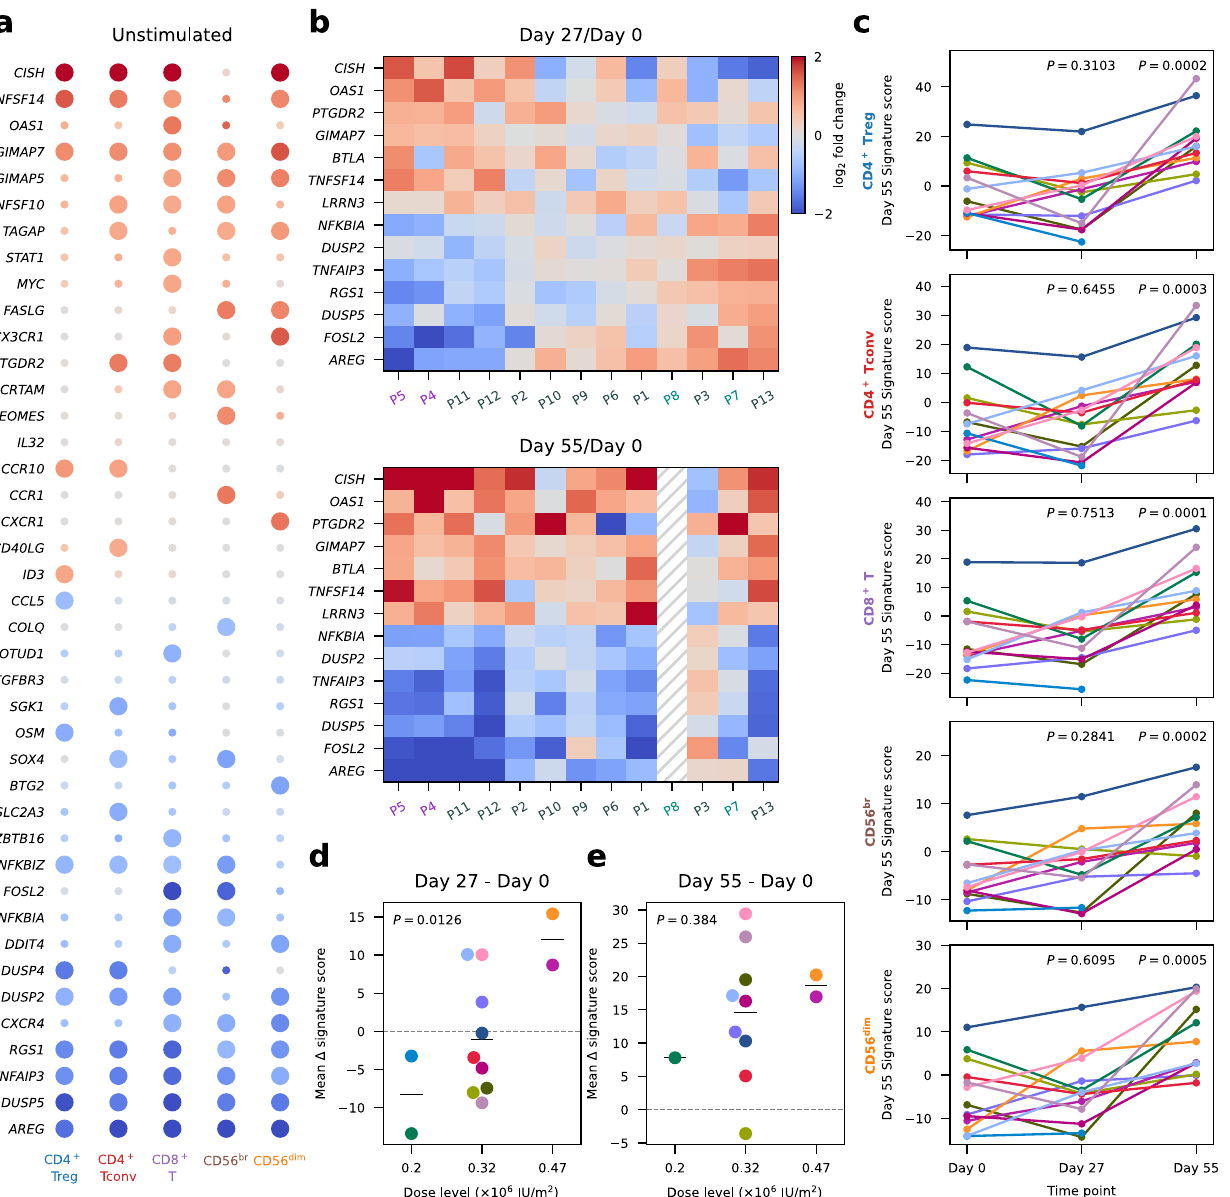
Fig. 6 | Interval low-dose IL-2 immunotherapy induces a long-lasting anti- in fl ammatory gene expression signature. a Differential expression of Day 55 signature genes. Day 55 signature genes were de fi ned as the 41 genes sig- ni fi cantly differentially expressed in at least one cell population comparing Day 55 with Day 0. Dot colours represent log 2 fold-change between Day 0 and Day 55. Larger dots represent signi fi cantlydifferentiallyexpressedgenes. Fold changeand P values were calculated using a generalized linear model implemented in DESeq2 (see “ Methods ” ). b Participant-speci fi c differential expression in CD8 + T cells comparing Day 27 (top panel) or Day 55 (bottom panel) with Day 0. Top 5 up- and downregulated genes as de fi ned by Day 55/Day 0 fold-change in CD8 + T cells. ParticipantlabelsarecolouredbytheirrespectiveIL-2dose(×10 6 IU/m 2 ):0.2(cyan),